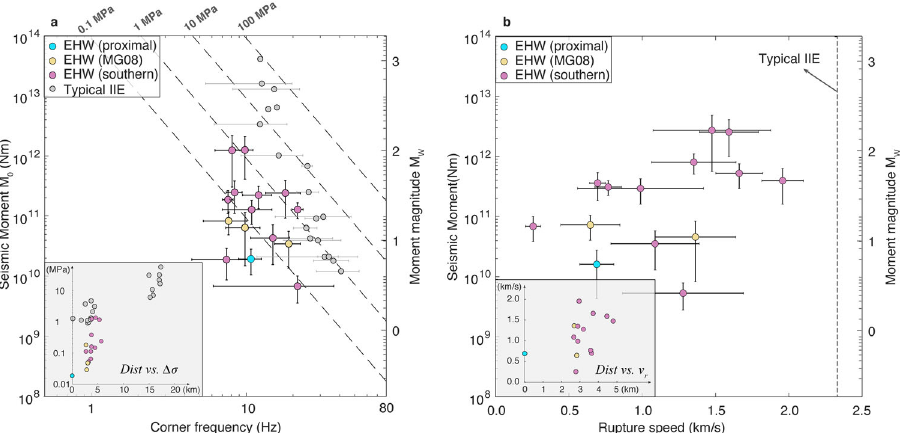
Fig. 4 Rupture characteristics of EHWs. a Scaling between corner frequency f c and seismic moment M 0 . Colored/gray dots: f c and M 0 estimated based on spectral ratio fi tting of S-phase for EHWs/typical induced events constrained using the same approach and data set. Error bars are consistent with Fig. 3. Inset: stress drop as a function of well distance. b Estimated rupture speed of EHWs. The dots and error bars are de fi ned the same as in a . Inset: rupture speed as a function of well distance.